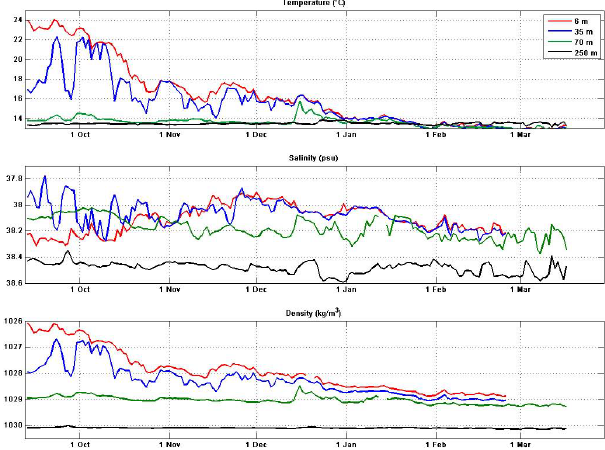
Fig. 3. Time series of daily mean data of sea temperature, salinity and density from 13th of September 2003 to 8th of March 2004 at 5m, 36m, 68m, and 250m depth. Data at 5 and 35m were collected from the sensors located on ODAS Buoy, the others from those located on the